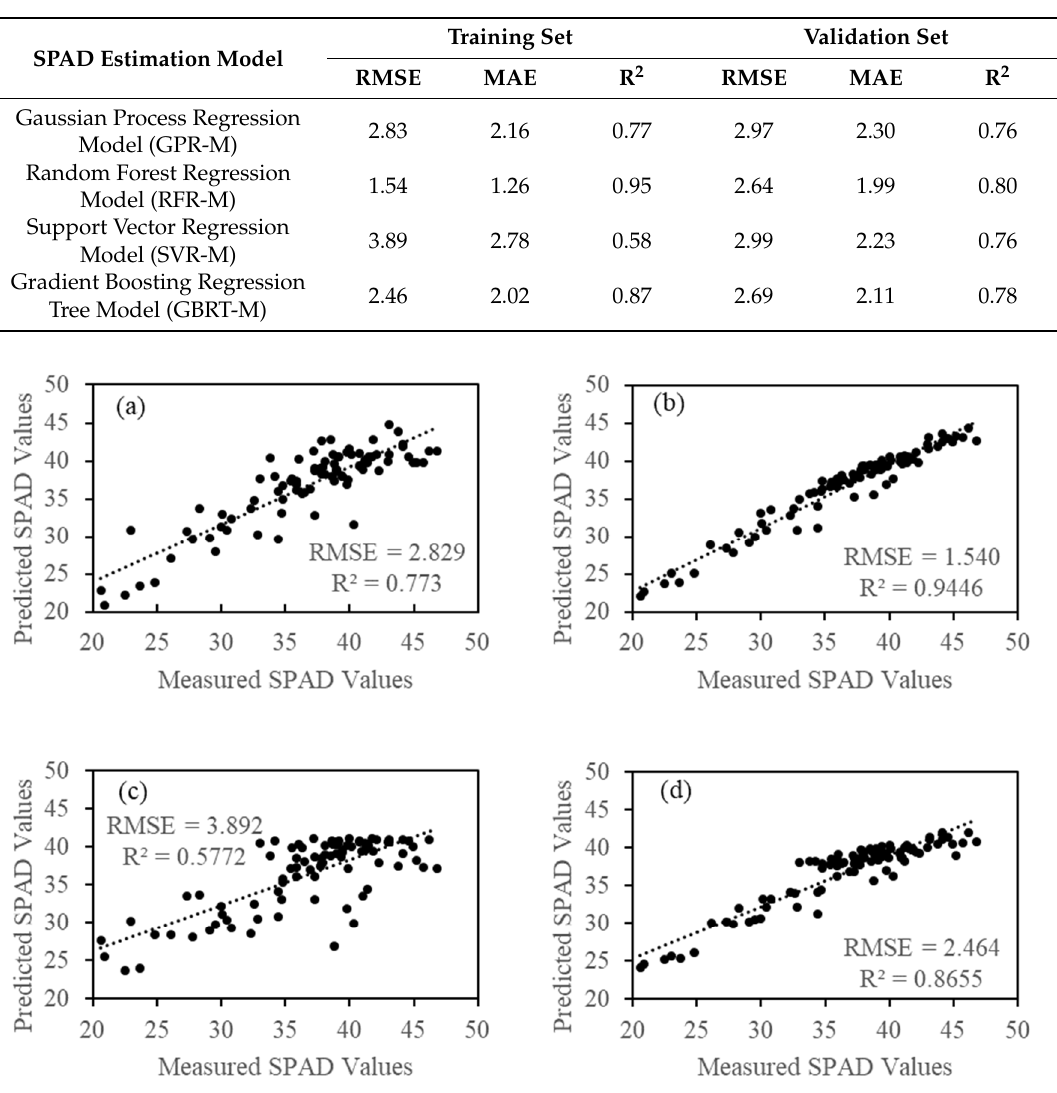
Figure 15. Scatterplots between the measured SPAD value and the predicted SPAD value using the training set. Note: ( a ) GPR-M; ( b ) RFR-M; ( c ) SVR-M; ( d ) GBRT-M.